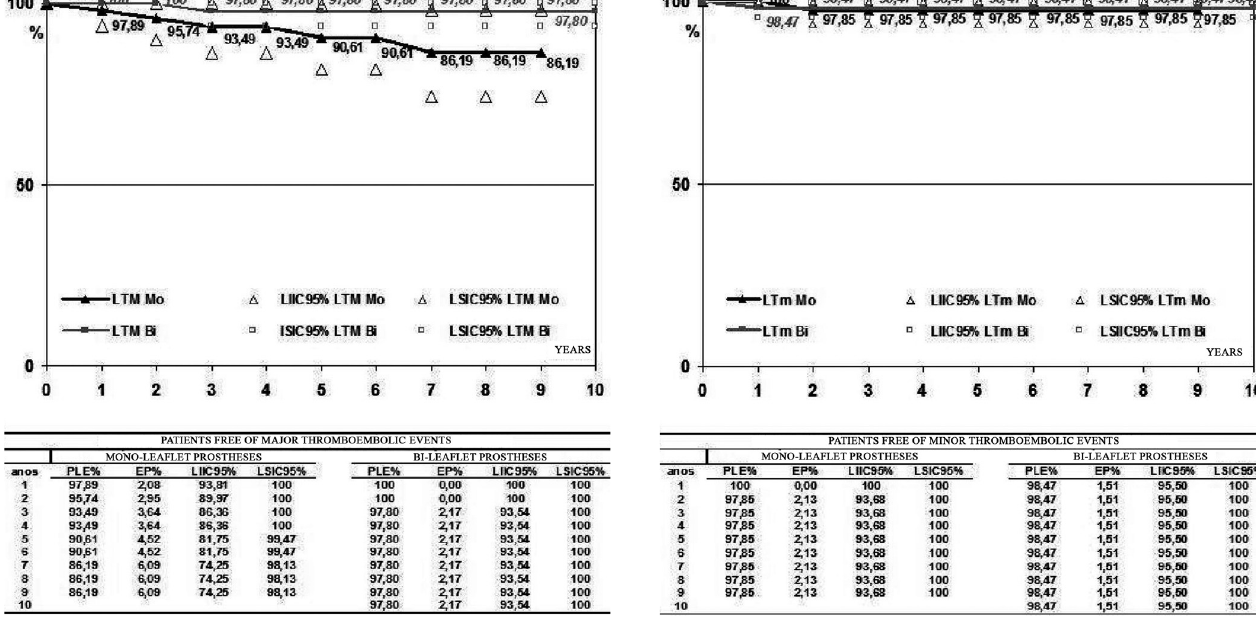
Fig. 3 - Curves and actuarial data showing the percentage of patients free of major thromboembolic events FMT (ordinate) with time - years (abscissa) for both types of prostheses studied. Mo = Mono-leaflet prosthesis; Bi = Bi-leaflet prosthesis; SE = standard error range; LLCI95% = lower limit of 95% Confidence Interval and ULCI95 % = Upper Limit of 95% Confidence Interval